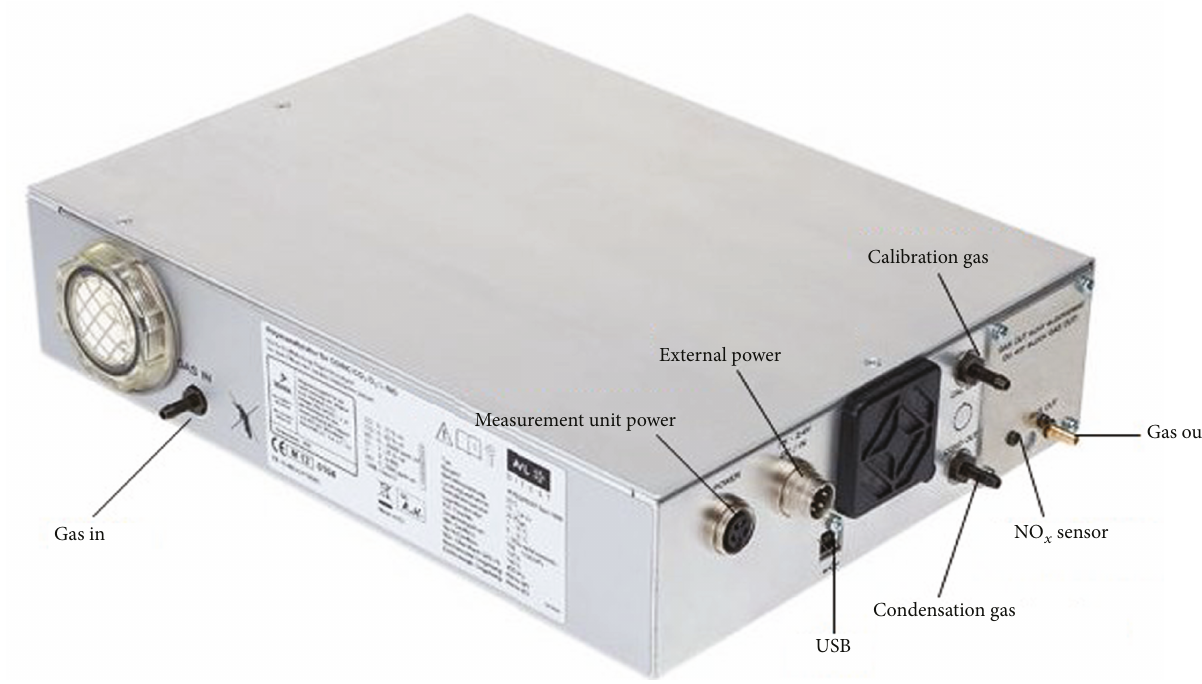
Figure 13: The measurement unit of AVL DITEST Gas 1000. Table 3: AVL439 main technical